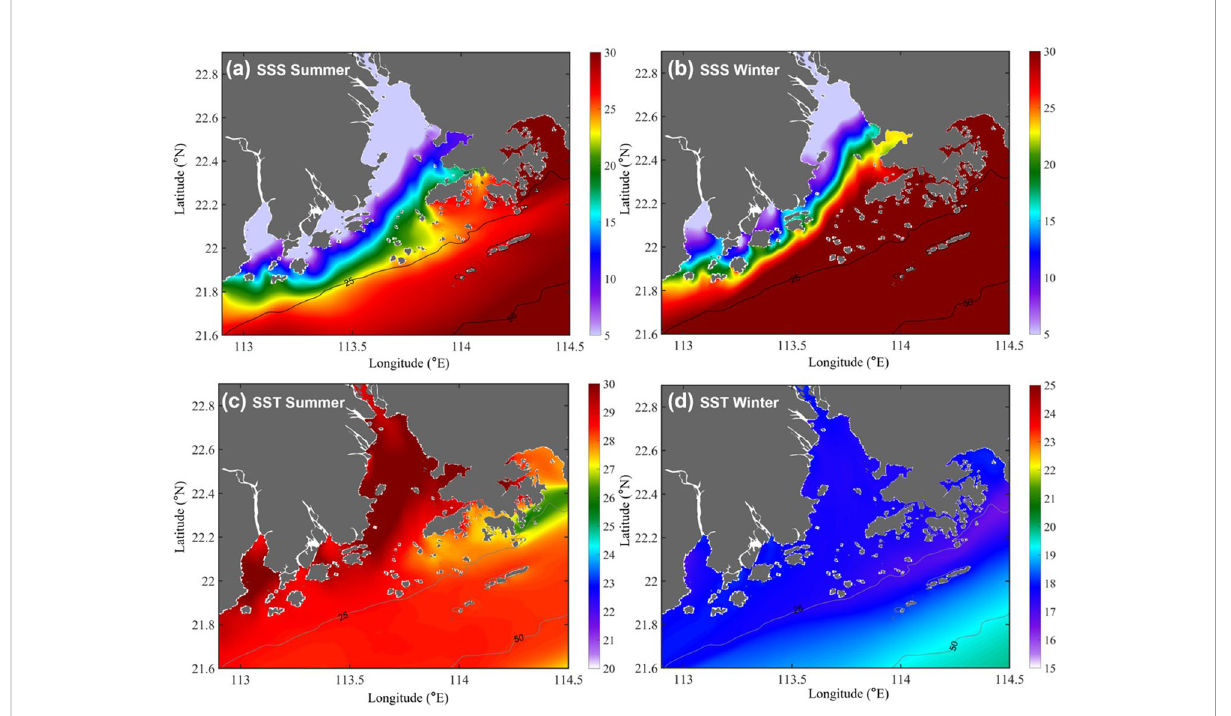
FIGURE 3 (A, B) Horizontal maps of the sea surface salinity (SSS, PSU) in summer and winter calculated by the numerical model in this study, respectively. (C, D) Same as (A, B) , except for the sea surface temperature (SST,